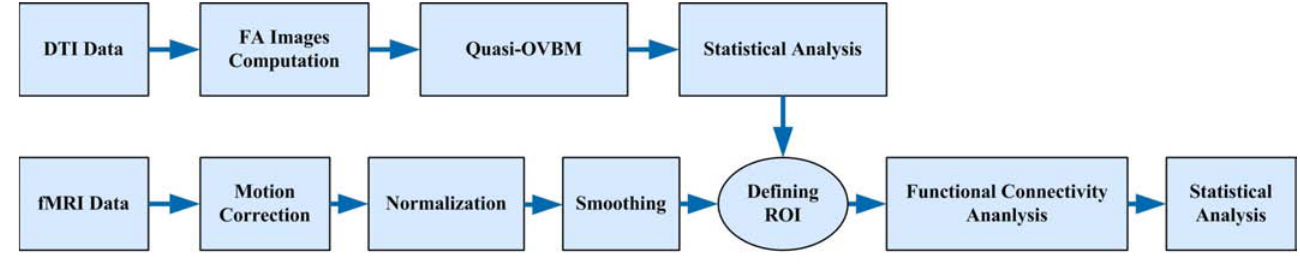
Figure 1: Data analysis procedures for combined fMRI data and DTI